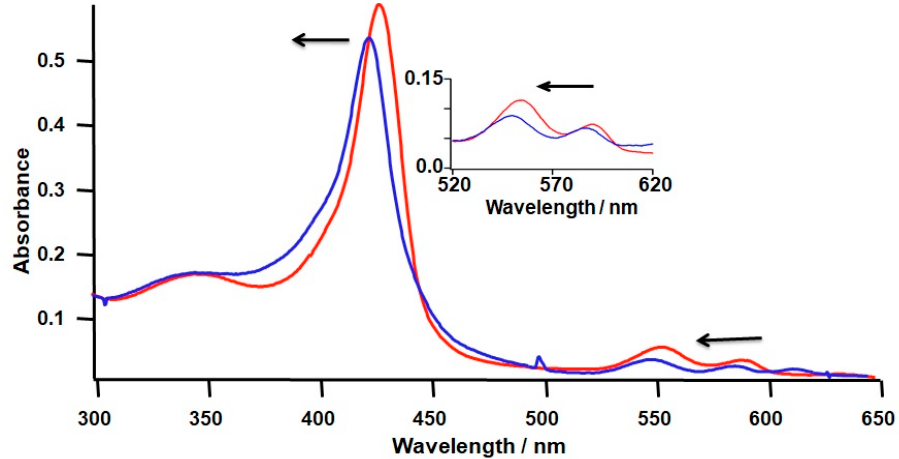
Figure 3. The spectral change of C14A reconstituted with Zn-PPIX. The UV-Vis spectrum immediately after the reconstitution (red line) shows spontaneous blue shift (blue line).